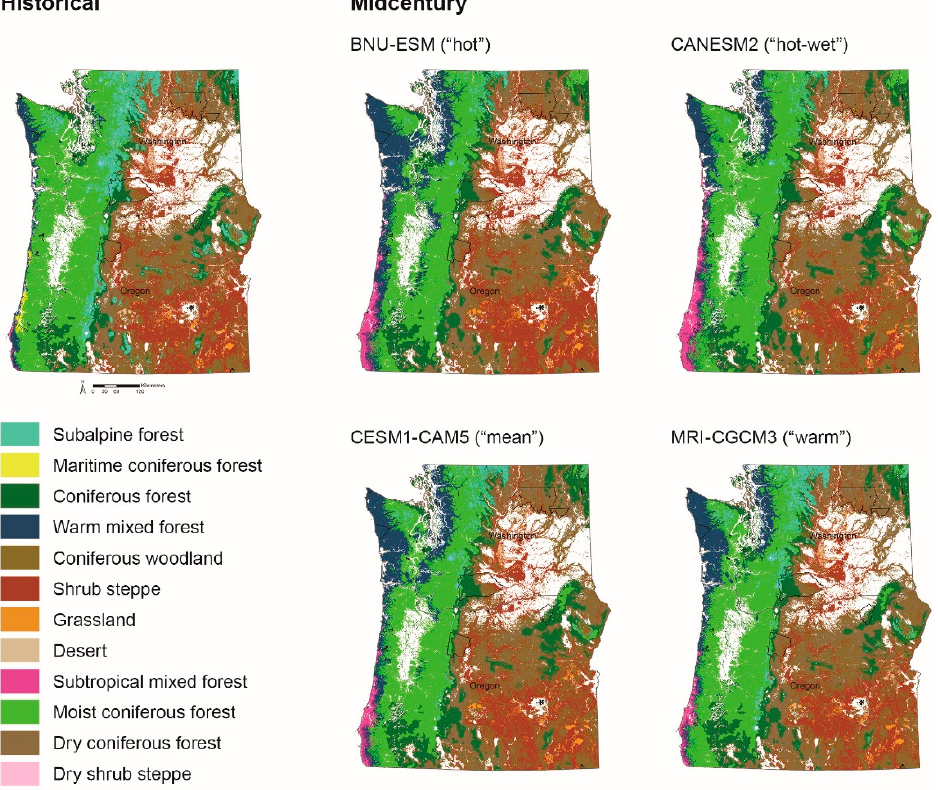
Figure 3. Historical (1970–1999) and midcentury (2035–2064) simulations of vegetation types across the study area for the BNU-ESM (“hot”), CanESM (“hot-wet”), CESM1-CAM5 (“mean”), and MRI-CGCM3 (“warm”) GCMs. Tribal reservations are delineated with black polygons.